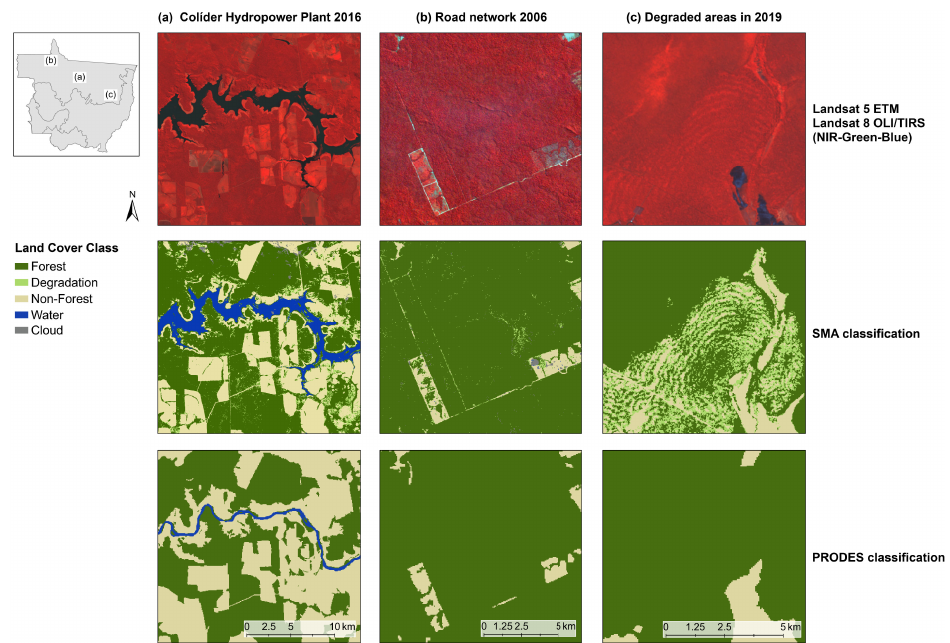
Figure 13. Comparison of PRODES and SMA classifications: ( a ) undetected Colíder Hydropower Plant by PRODES in 2016; ( b ) unmapped road courses in the PRODES dataset of 2006; ( c ) differences in the classification of degraded forest areas between the SMA and PRODES classification in 2019 (data from [54,55,89], Landsat 5 TM and Landsat 8 OLI/TIRS images from 18 July 2006, 15 June 2017 and 26 July